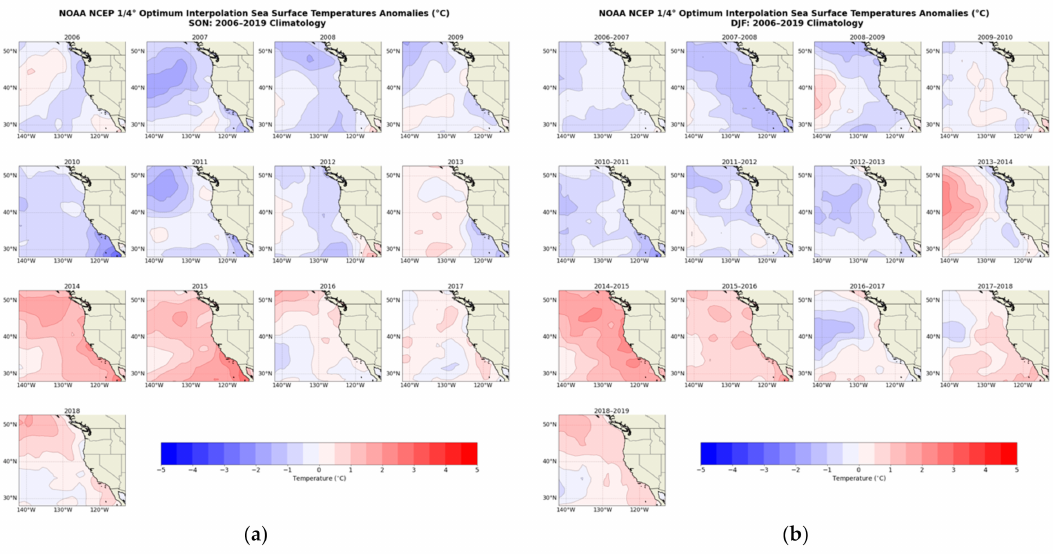
Figure 9. NOAA Optimum Interpolation (OI) sea surface temperature anomalies from 2006–2019 valid for ( a ) SON and ( b )